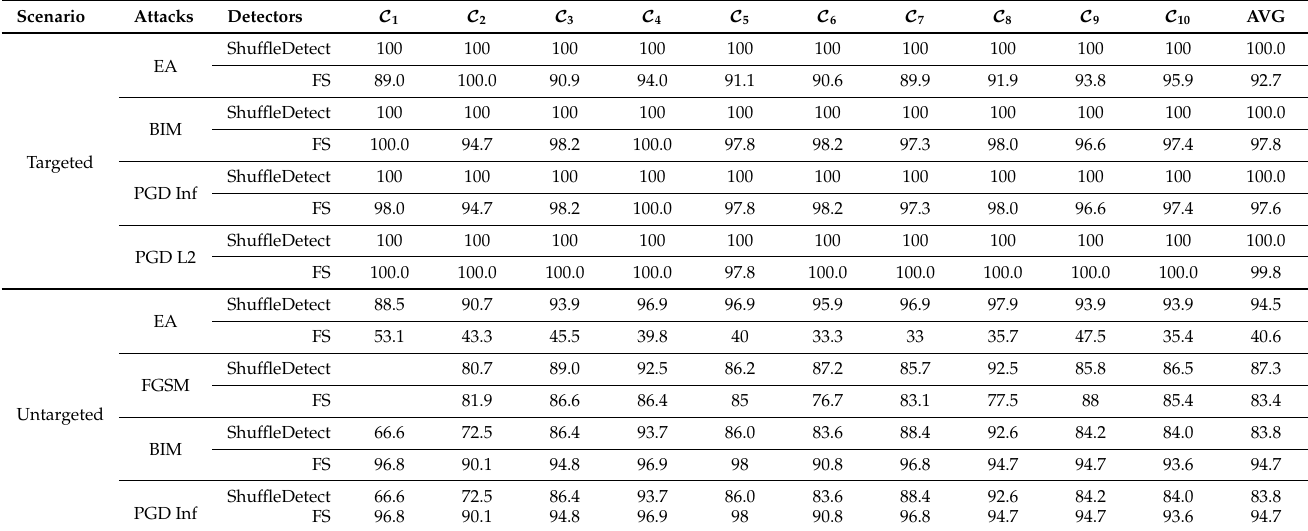
Table 17. Performance comparison of ShuffleDetect and FS regarding detection